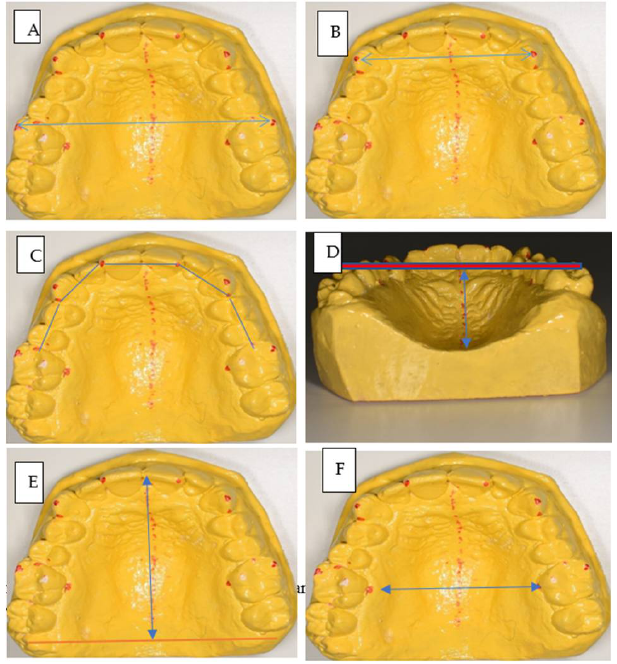
Figure 1. Measurements, ( A ) inter-molar width, ( B ) inter-canine width, ( C ) arch perimeter, ( D ) palatal depth, ( E ) palatal length, ( F ) palatal width.